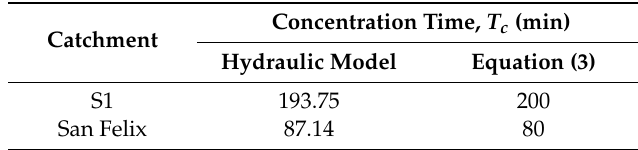
Table 4. Comparison of the modified concentration time.